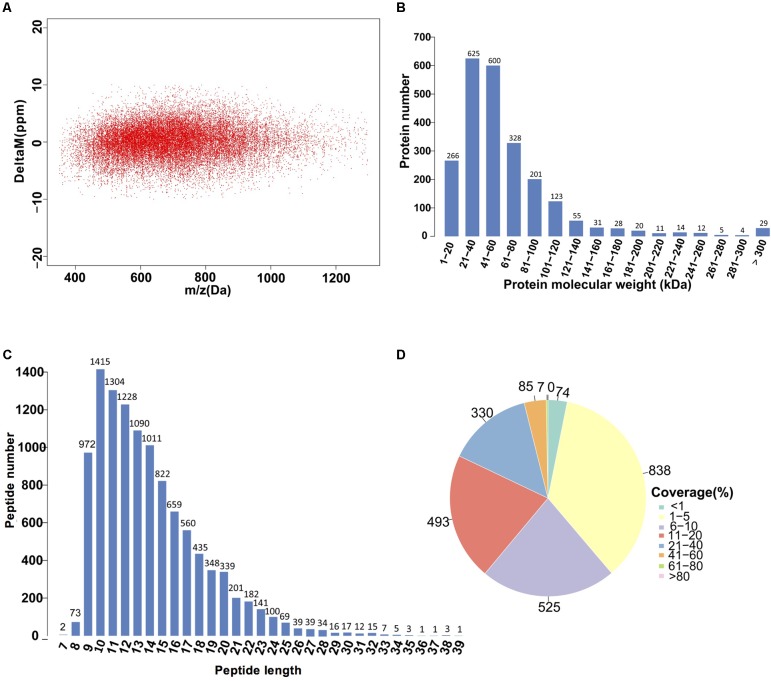
Identification and analysis of the proteome in PF and SF. (A) Distribution of peptide segment matching error. (B) The distribution of protein molecular weight. The x-axis shows the size of the identified protein molecular weight (unit: kilodalton, kDa), and the y-axis represents the number of identified proteins responsed for the corresponding size. (C) The distribution of peptide length. The x-axis indicates the length of the peptide (the number of amino acids), and the y-axis indicates the ratio of the peptide length to the total number of peptides. (D) Distribution of the protein sequence coverage. The number outside the fan indicates the coverage of the protein number in this interval.